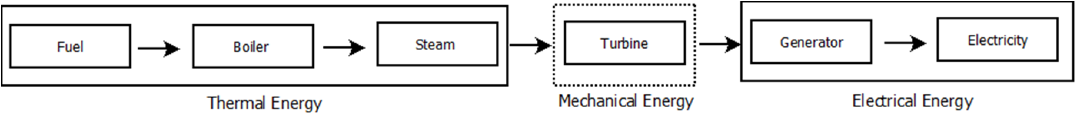
Figure 1. Schematic illustration of energy conversion in a thermal power plant .